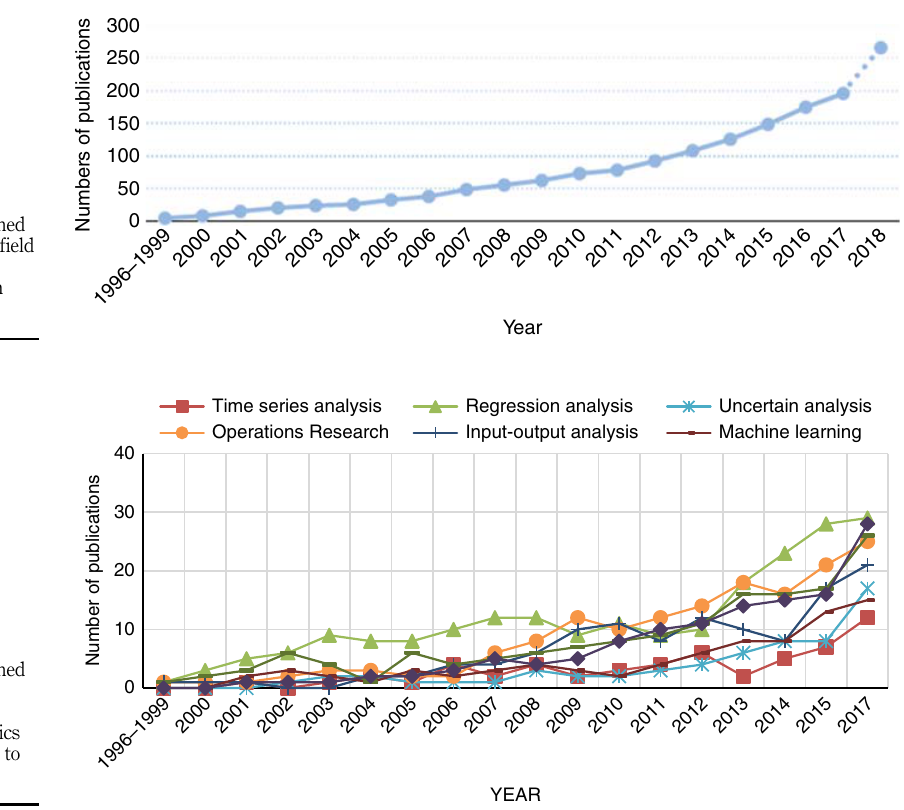
Figure 2. Number of published documents for methods used in marine econometrics studies from 1996